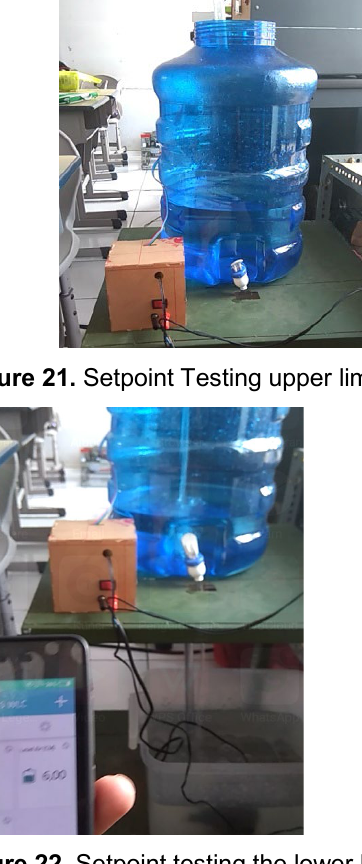
Figure 22. Setpoint testing the lower limit of 5cm b. Test with setpoint upper limit 15 cm and lower limit 6 cm The second test is when the water level reaches 15 cm, the pump will die and when the water level has reached the bottom limit of water, which is 5 cm, the pump will turn on.